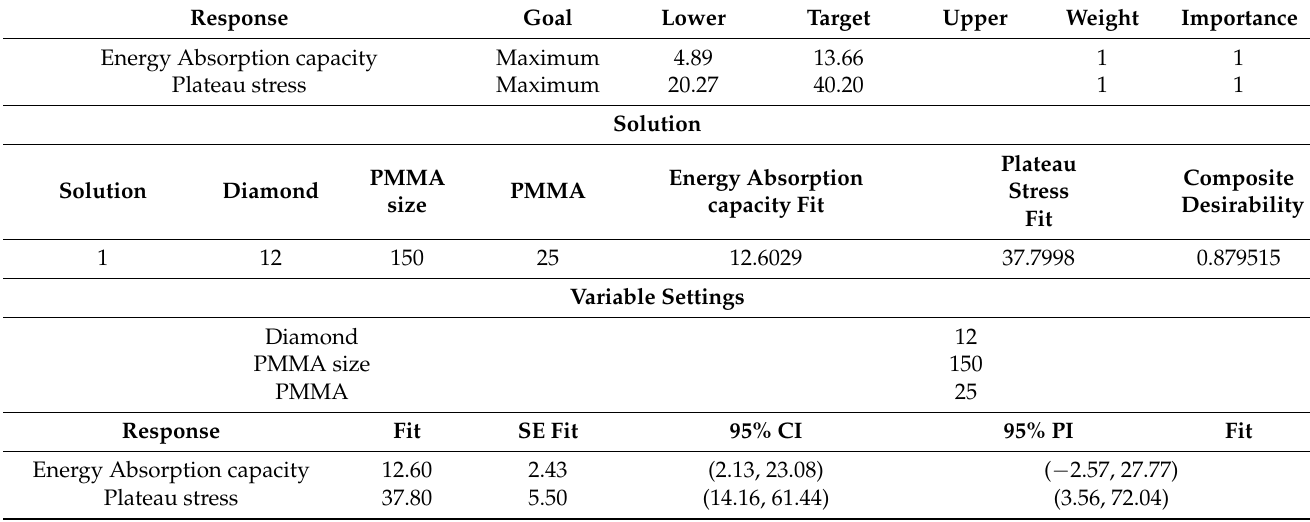
Table 9. Response optimization: composition and